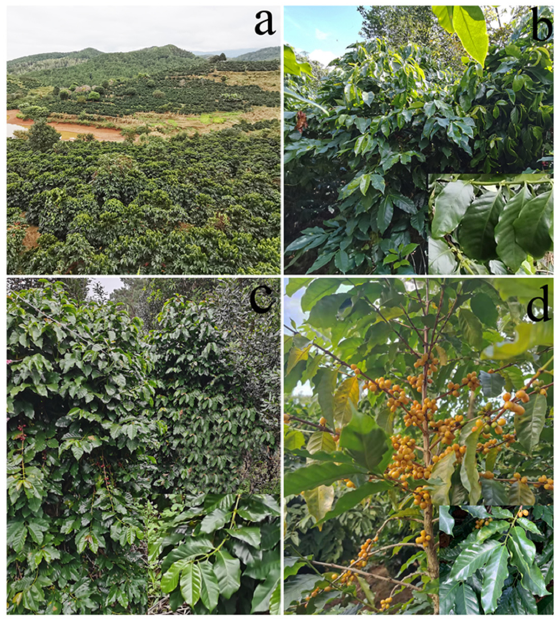
Figure 1. ( a ) Aerial view of a coffee plantation in Pu’er city; ( b ) Arabica coffee trees; ( c ) Catimor coffee trees; ( d ) Yellow Bourbon coffee trees. Table 1. Information on the host species and sample collection